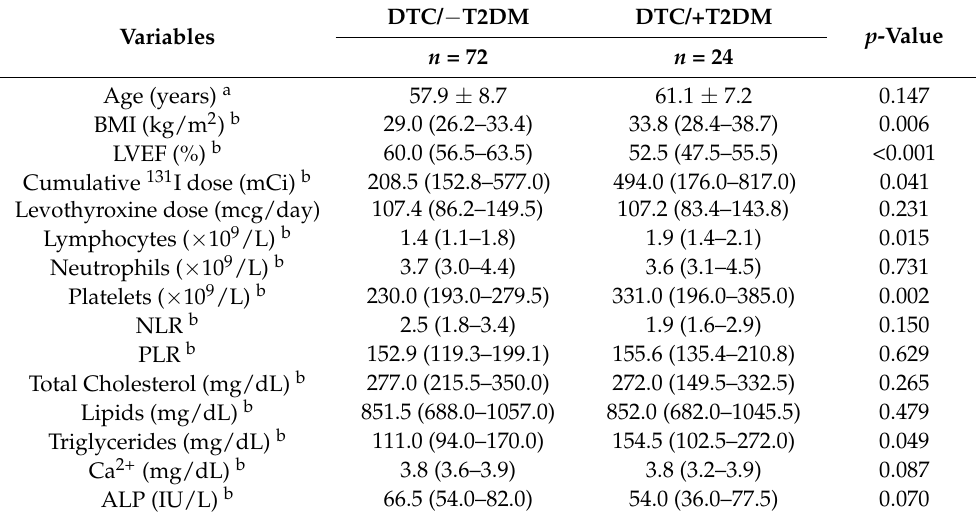
Table 1. Clinical, hematological, and biochemical data in the study groups.